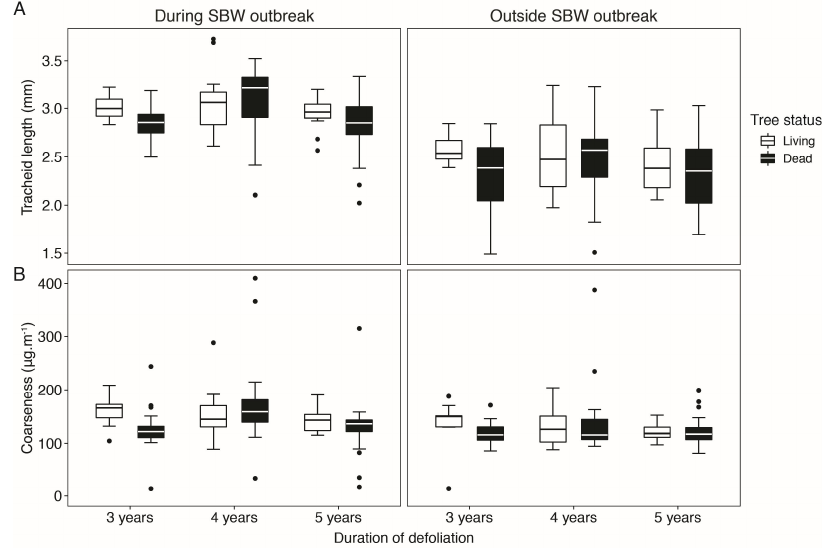
Figure 4. ( A ) Tracheid length and ( B ) coarseness of wood produced during and outside of a spruce budworm (SBW) outbreak of trees visually classified as living and dead from stands that have been defoliated for three, four or five years.